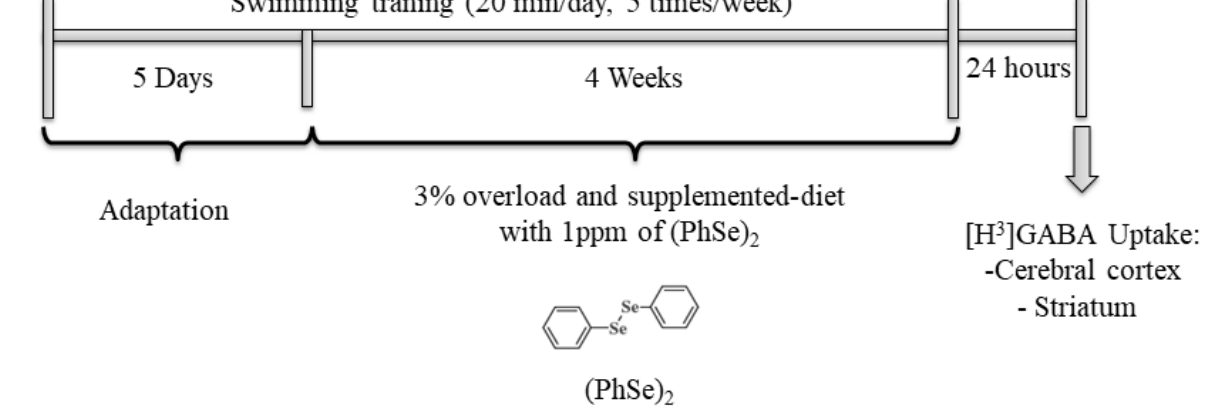
Figure 1. Schematic representation of the experimental design of this